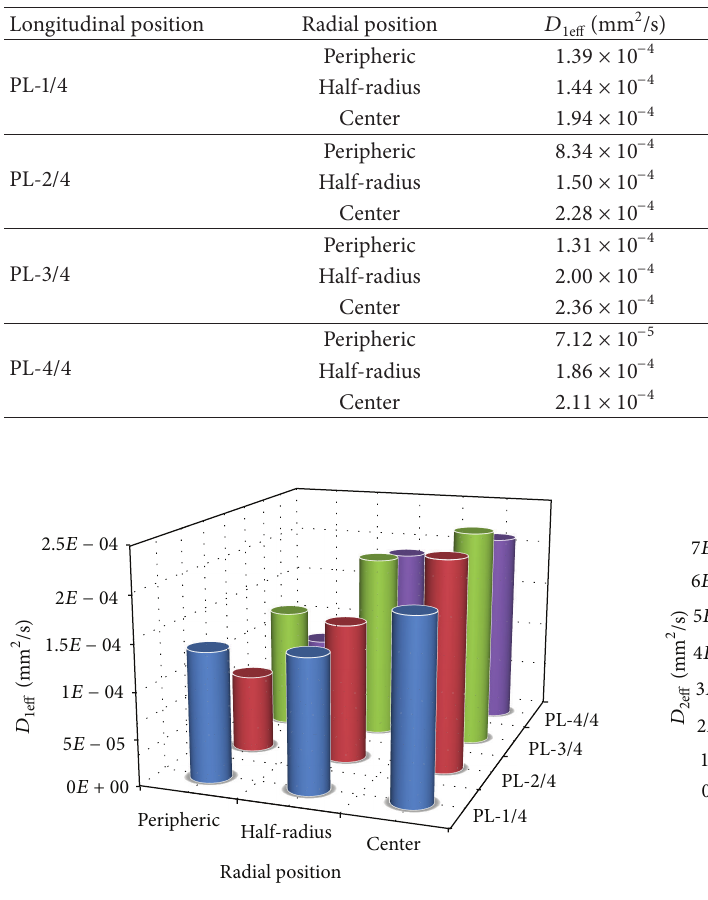
Table 6: Effective diffusion coefficients of initial and final phases and the other parameters of Raffia vinifera fibres obtained by the method of dual stage diffusion Fick’s law model along the stem.